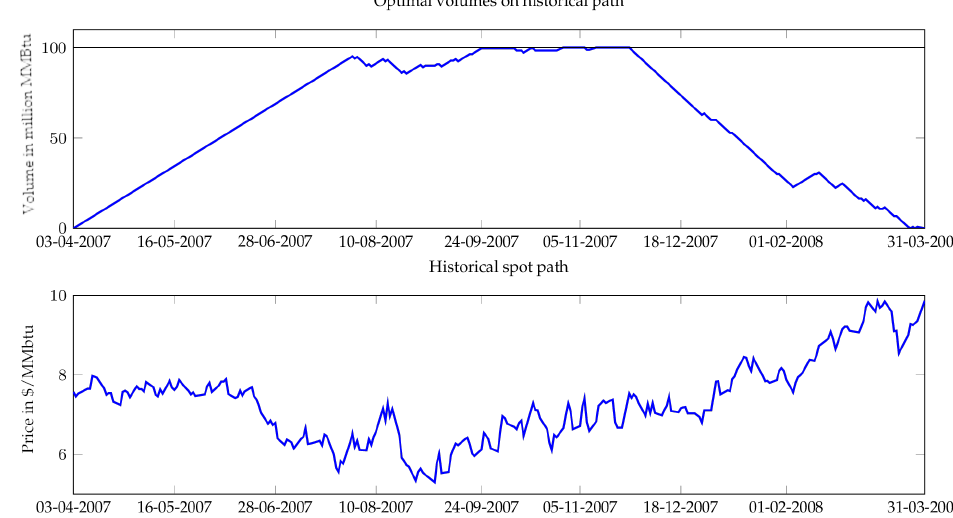
Figure 7. Historical spot path and optimal volumes (slow storage). bottom panel: historical path, top panel: the optimal storage level on the historical